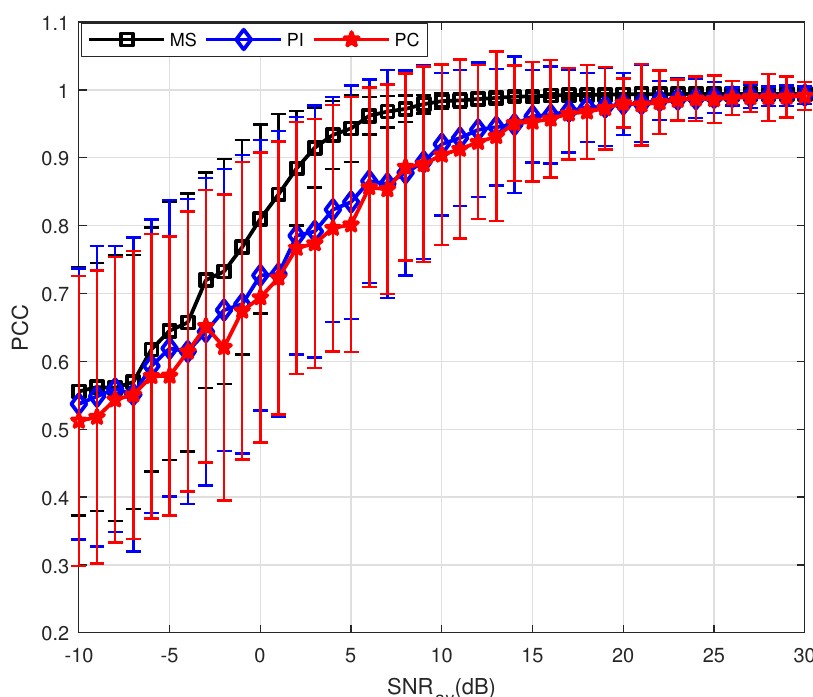
Figure 6. Results of three PSM estimation methods where P =